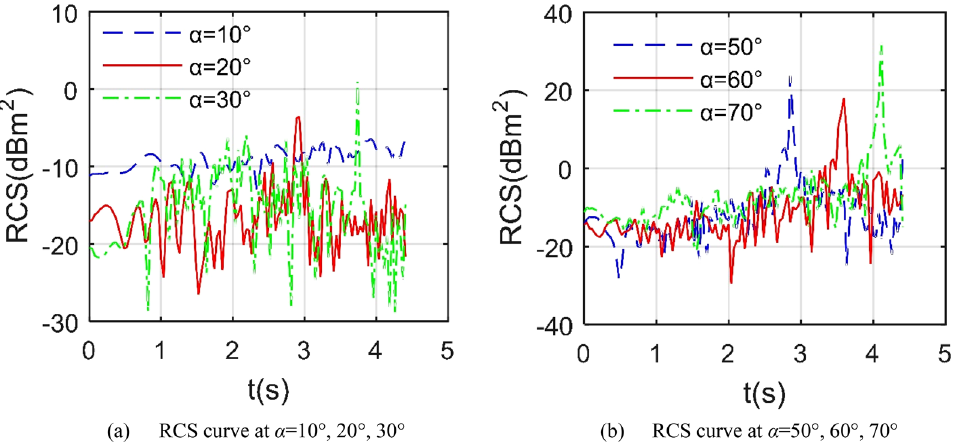
Figure 8. The influence of different azimuths on dynamic RCS of the aircraft in Z1 mode, β = 0°, f RH = 6 GHz, ω